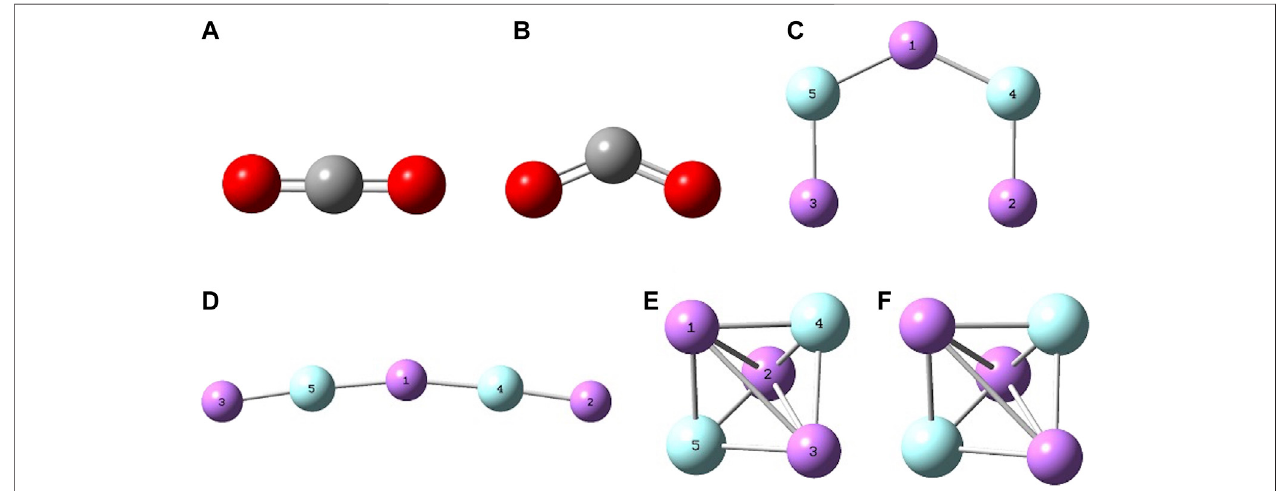
FIGURE 1 | B3LYP/6-31G* optimized geometries of (A) CO 2 , (B) CO 2 − , (C) Li 3 F 2 (C 2v ), (D) Li 3 F 2+ (C 2v ), (E) Li 3 F 2 (D 3h ), (F) Li 3 F 2+ (D 3h ).